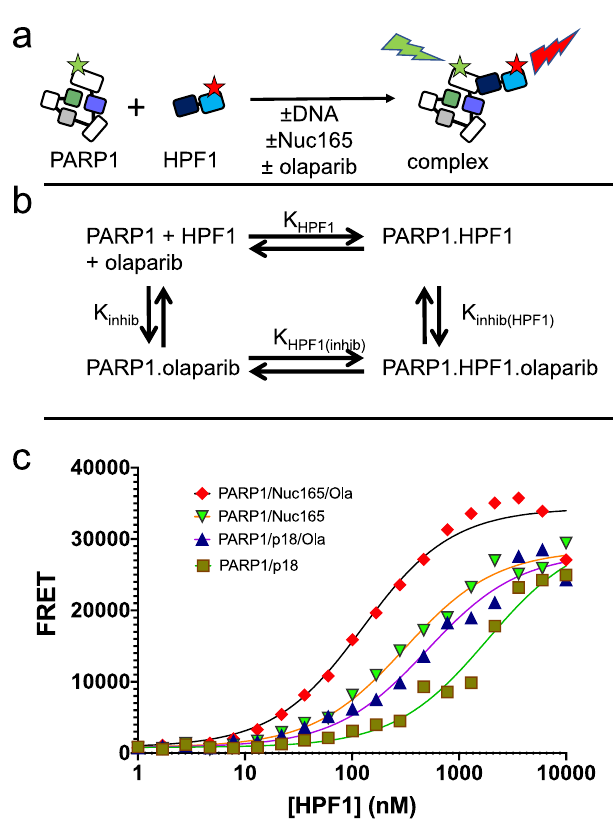
Fig. 3 Olaparib increases the effective binding constant of HPF1 for PARP1 in the presence of Nuc165 or p18mer DNA. a Schematic for the FRET-based assay utilized to measure the binding of HPF1 to PARP1 in the presence or absence of DNA or nucleosomes. b Diagram of the thermodynamic box that allows for interpretation that tighter binding of HPF1 in the presence of olaparib implies tighter binding of olaparib in the presence of HPF1 (K HPF1 * K inhib(HPF1) = K inhib * K HPF1(inhib) ). c Representative FRET data demonstrating that the presence of olaparib leads to tighter binding of HPF1 to a PARP1 — Nuc165 or a PARP1 — p18mer complex. Binding constants, errors, and statistical signi fi cance from multiple replicates are enumerated in the